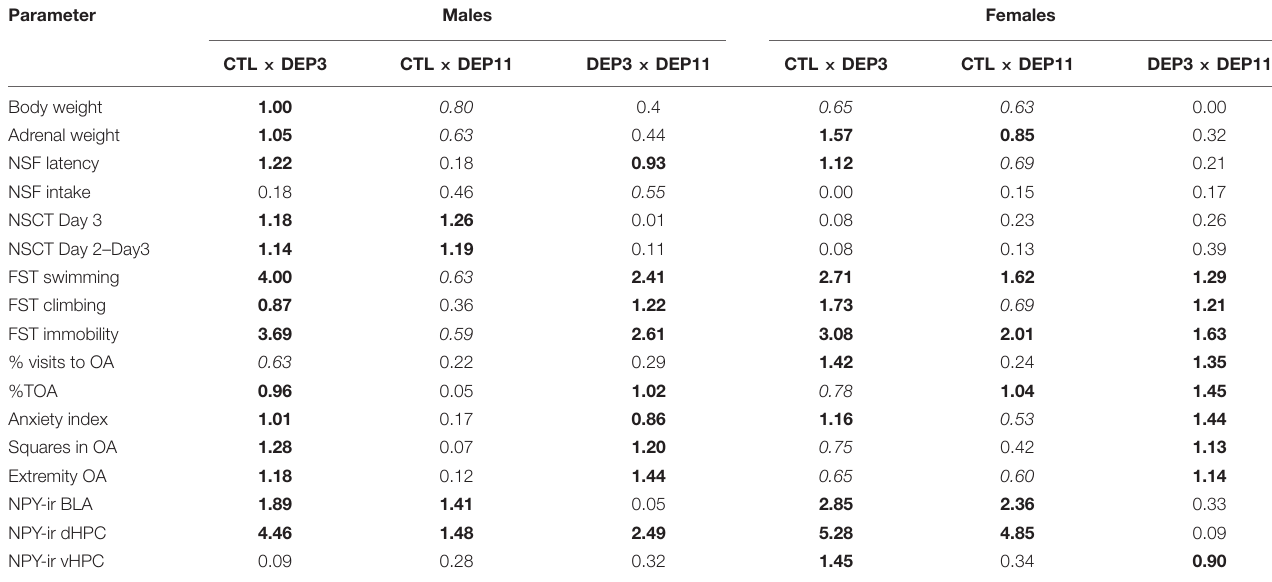
TABLE 4 | Pairwise calculation of Cohen’s d effect size.